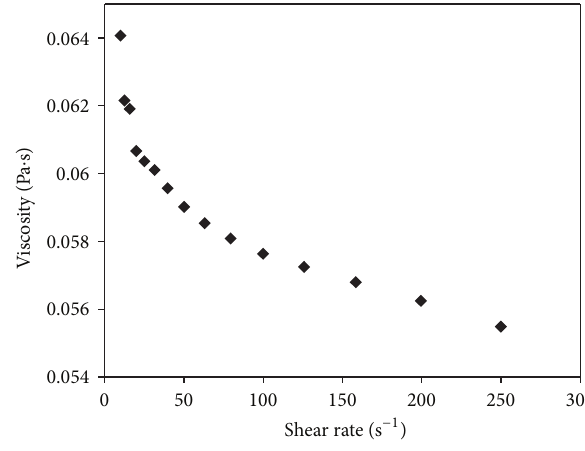
Figure 4: TGA analysis of [BMIM]Cl.